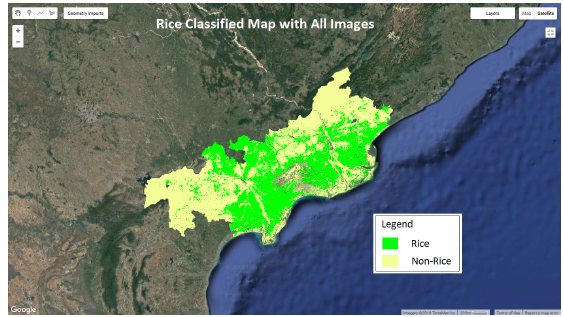
Figure 11. Rice Classified Map with All Images